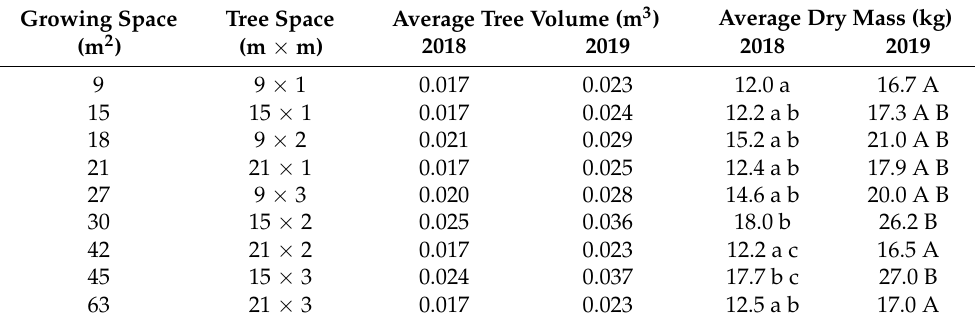
Table 2. Volume and absolute dry mass of individual black locust trees at the ages of 4 and 5. The data is ordered by ascending order of growing space ( α = 0.05; 2018: n = 272; 2019: n =